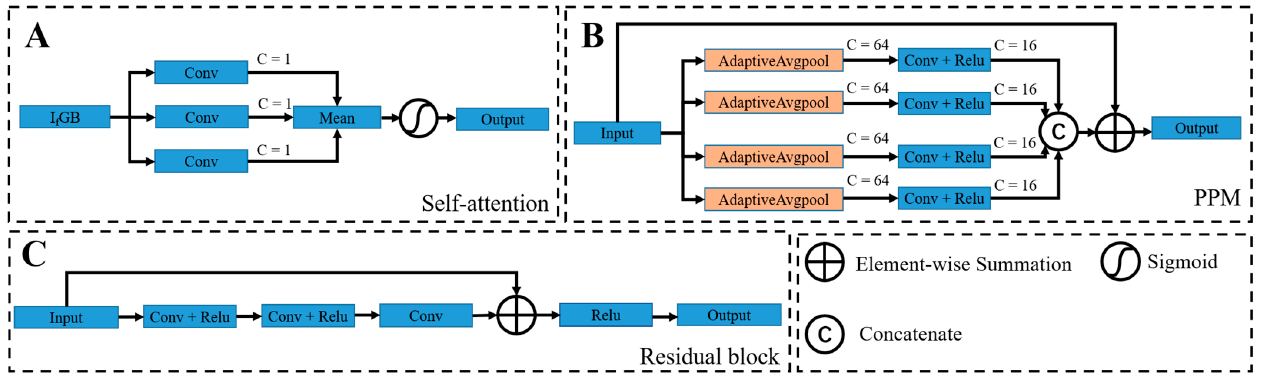
Figure 4. The required modules in Figure 3. It contains the self-attention mechanism ( A ), the PPM module ( B ), and the residual block ( C ). Among them, ‘C’ denotes the channel; ‘Mean’ in the blue block in A indicates the operation of taking the feature to mean; the output of PPM and residual block does not change the number of channels.